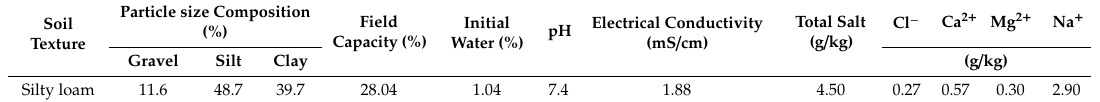
Table 1. Basic physicochemical properties of the experimental